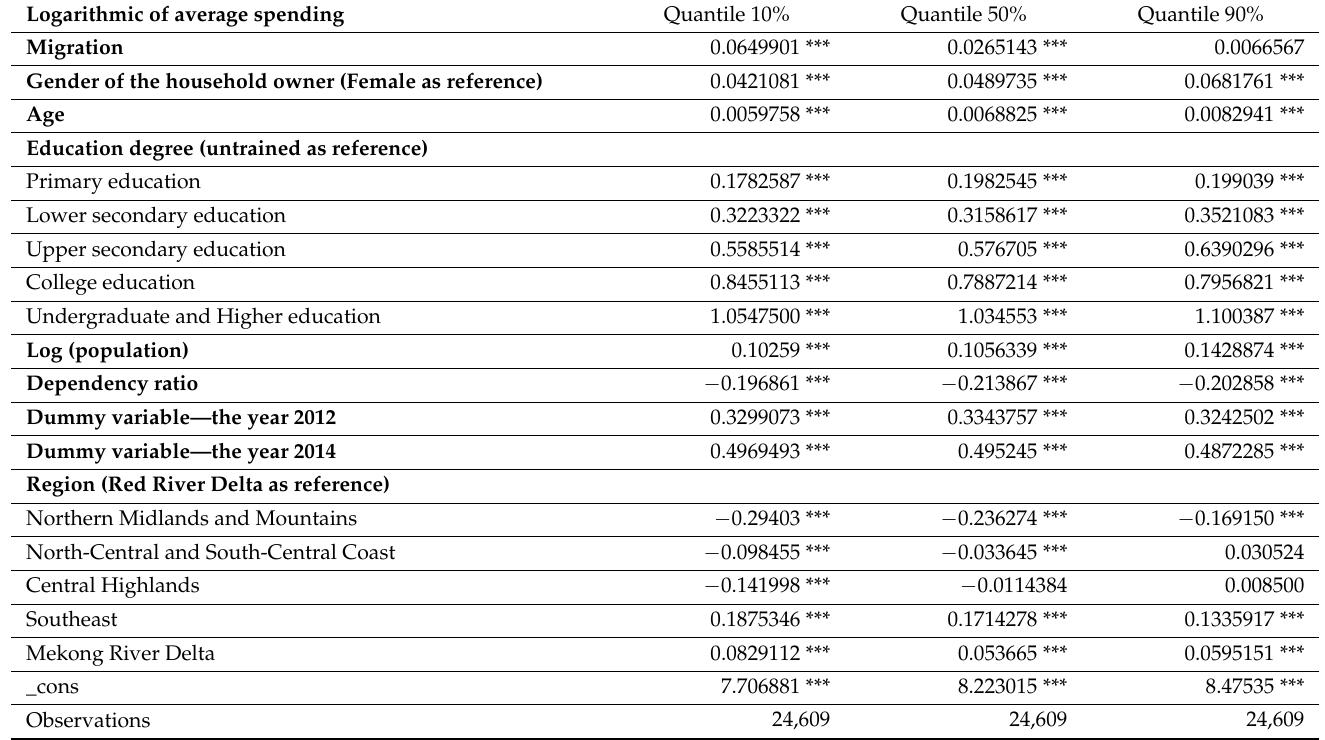
Table 2. Results of quantile